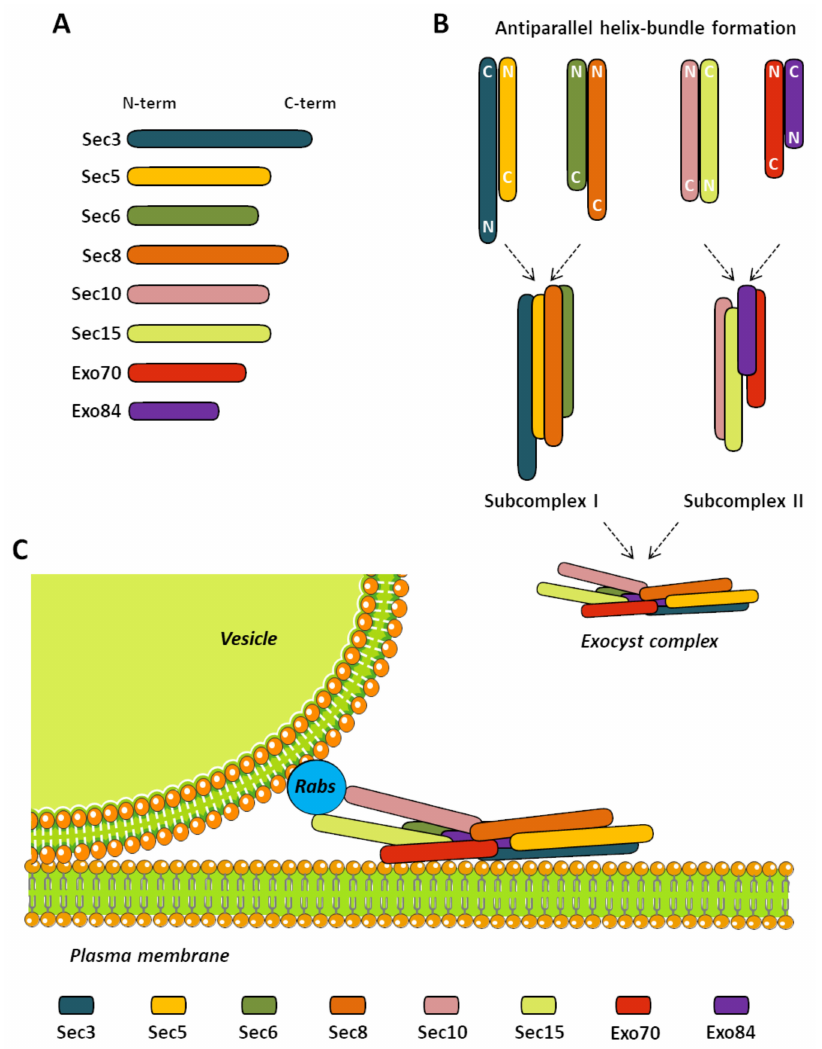
Figure 3. The exocyst complex. ( A ) Bars are examples of the scaled size corresponding to each subunit. ( B ) The scheme depicts antiparallel helix-bundle formation in the assembly of the exocyst complex. Subunit positioning corresponds to an approximation of the interaction experiments discussed in this review. Primary pairs are formed by Sec3–Sec5, Sec6–Sec8, Sec10–Sec15, and Exo70–Exo84. These pairs interact closely to induce the formation of the subcomplexes 1 and 2. Then, both subcomplexes bind together to finally stabilize the functional exocyst complex. ( C ) A cartoon of the exocyst complex is shown. The exocyst acts by tethering secretory vesicles to the plasma membrane in specific sites where the cargo is needed. The model shows a rod-like molecular structure of the subunits. In this model, Sec3 and Exo70 target the exocyst to the plasma membrane. An opposite positioning of Sec10 and Sec15 is observed compared to Sec3 and Exo70; this positioning is vital to the contact of the exocyst with the vesicles where Sec15 interacts with several Rabs to be its e ff ector